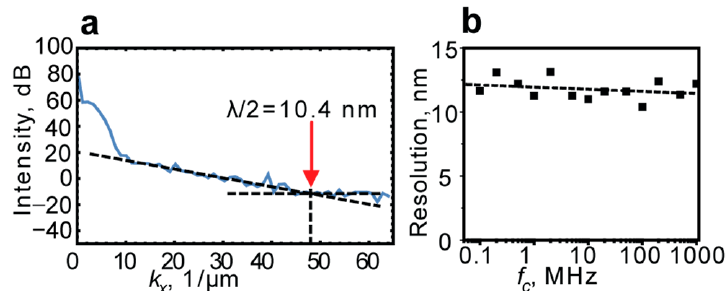
Figure 4. Power spectrum for amplitude modulated 100 MHz signal with calculated spatial resolution ( a ). The frequency dependence of spatial resolution ( b ).